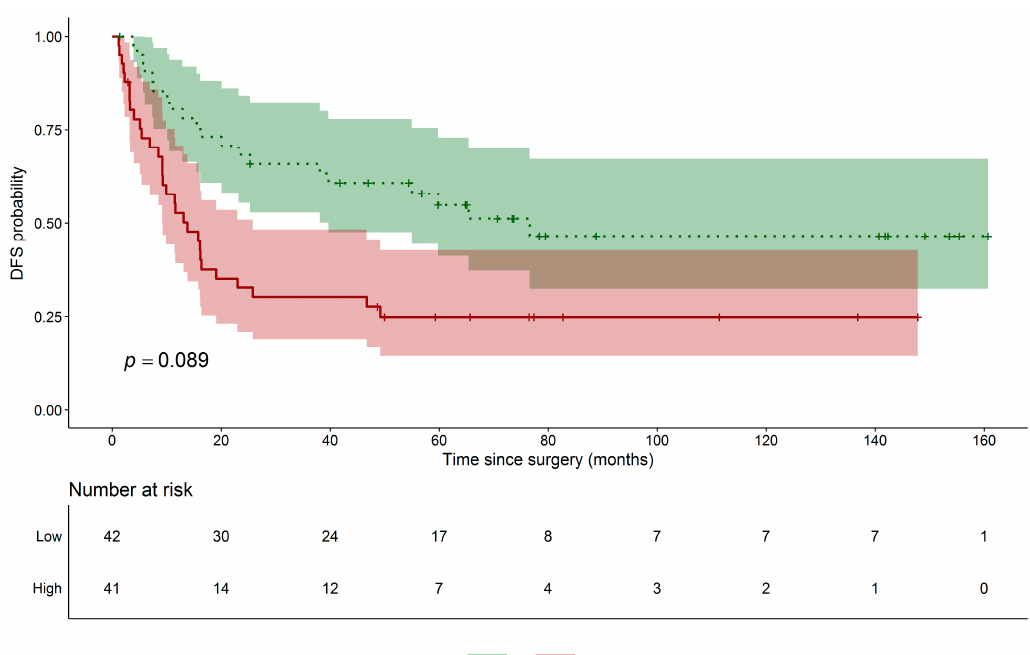
Figure 1. DFS Kaplan–Meier curves for SCC patients. Disease-free survival risk table and leave-one-out cross-validated Kaplan–Meier curves for SCC high (red solid line) and low risk (green dotted line) patients groups along with their 95% confidence interval (accordingly shaded areas); permutated log-rank p -value for the hypothesis testing of equality of curves between groups is also reported.